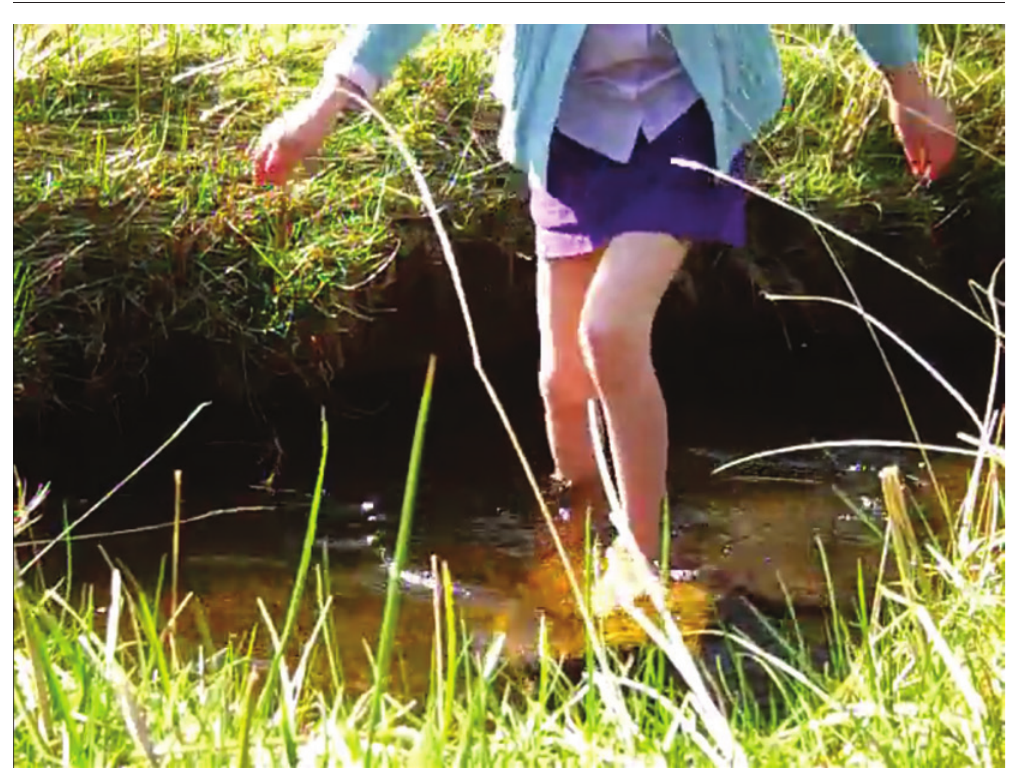
Figure 1: Poetic framings in Blue